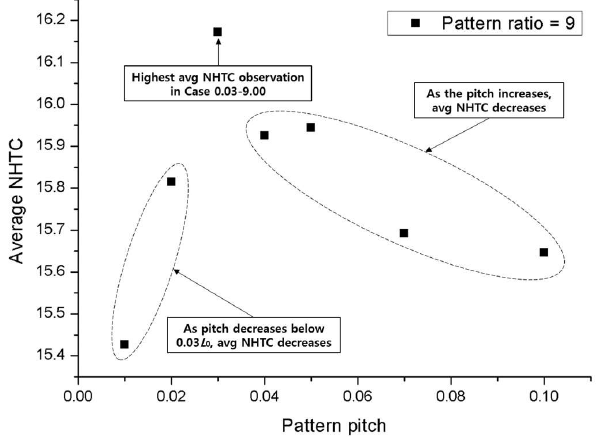
Figure 9. Average normalized heat transfer coefficient according to the pattern pitch in 9.00 pattern ratio.